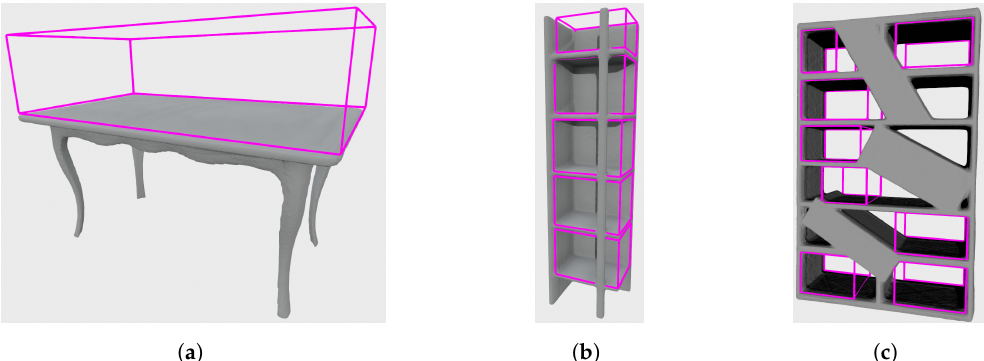
Figure 8. Examples of labeled ground truth annotations (purple bounding boxes) of storage volumes in selected furniture models: ( a ) Table, ( b ) Bookshelf A, ( c ) Bookshelf